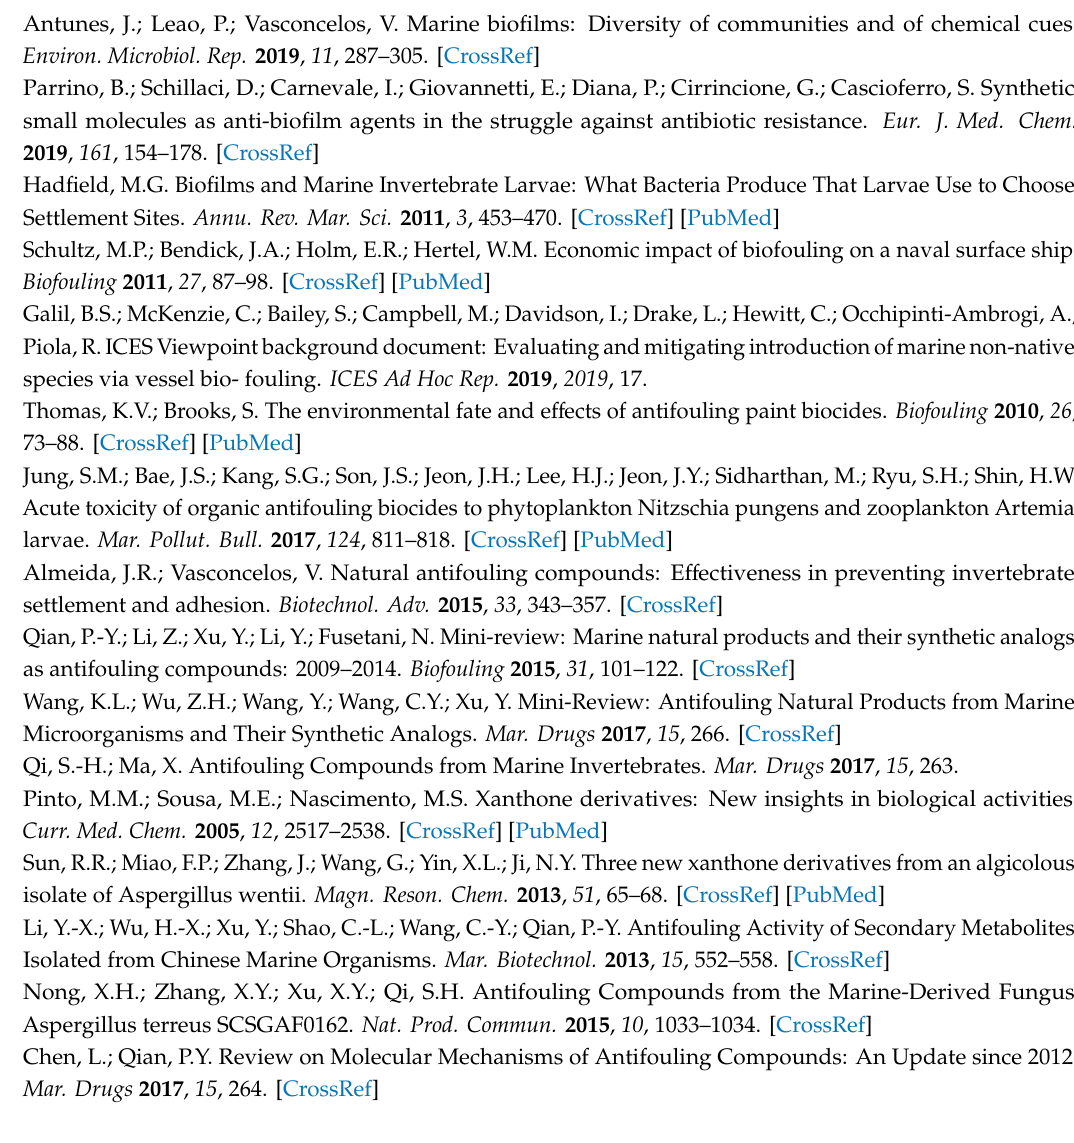
Table S1: NSAF values and Kruskal-wallis p-values of all di ff erentially abundant proteins. Table S2: Blast search results with the tools blast2go and blastp from